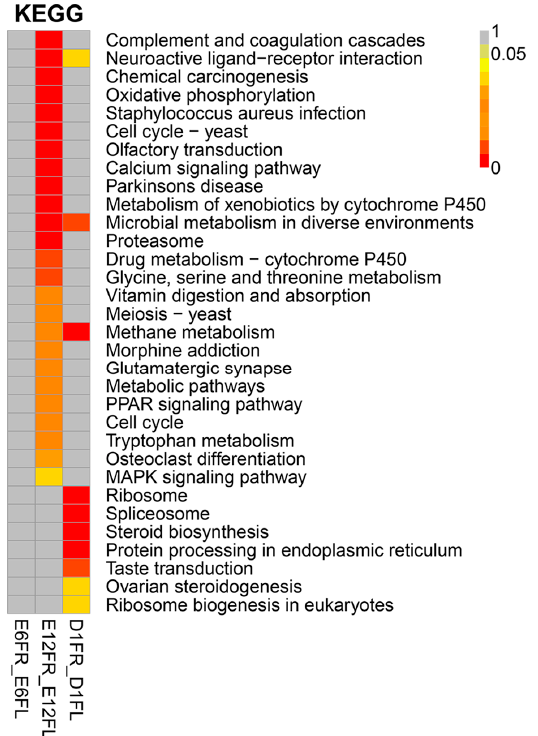
Figure 4. Heatmap of Kyoto Encyclopedia of Genes and Genomes (KEGG) annotations for DEGs between the left and right gonads. Each row represents a metabolic pathway. Different colors represent the q -value. E6FR_E6FL, E6FR vs. E6FL; E12FR_E12FL, E12FR vs. E12FL; D1FR_D1FL, D1FR vs. D1FL.